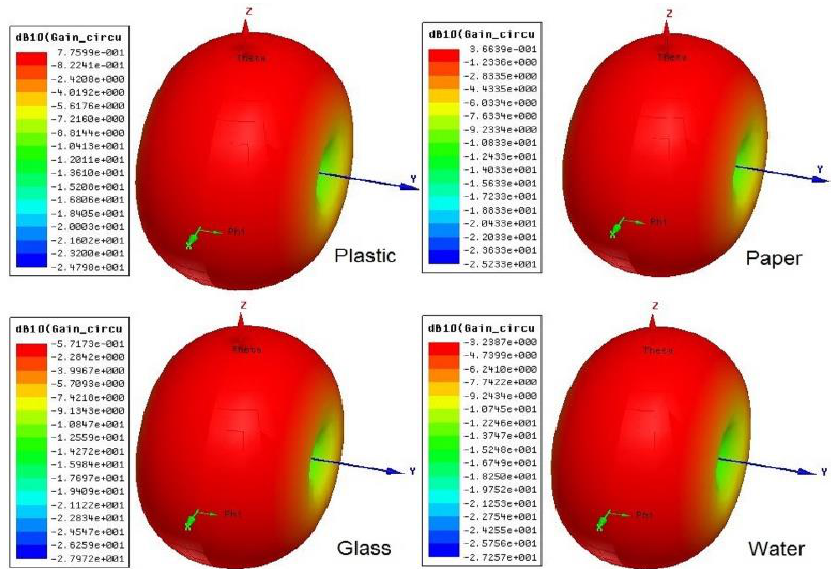
Figure 15. Torus-shaped omnidirectional radiating pattern of antenna gain for North American UHF RFID tag on several mounting platforms: 0.77 dB (2.92 dBi) for plastic; 0.36 dB (2.51 dBi) for paper; −0.5 dB (1.58 dBi) for glass; and −3.2 dB (−1.05 dBi) for water.